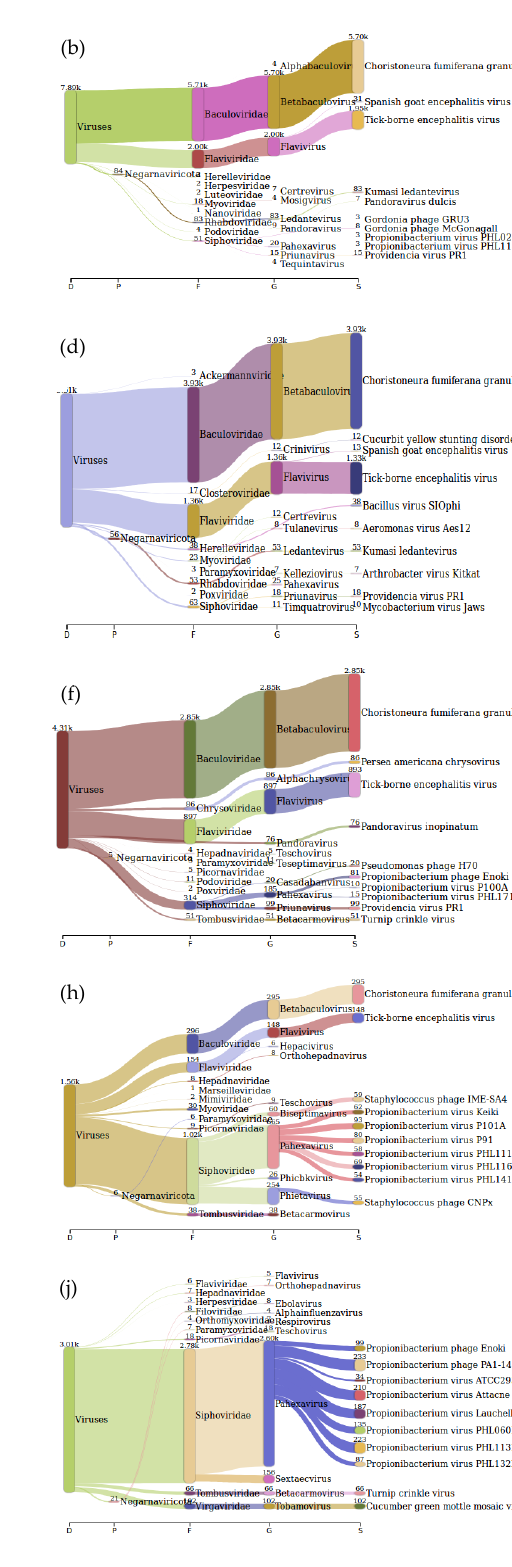
Figure 5. Sankey diagrams of Kraken 2 report results obtained for sensitivity of the sample preparation pipeline using tick-borne encephalitis virus (TBEV) positive tick homogenate. Panel ( a , b ) represent duplicate mNGS results of TBEV positive tick homogenate with Ct value 27.22, panel ( c , d ) of sample with Ct value 30.59, panel ( e , f ) of sample with Ct value 34.0, panel ( g , h ) of sample with Ct value 37.29, and panel ( i , j ) of sample with Ct value